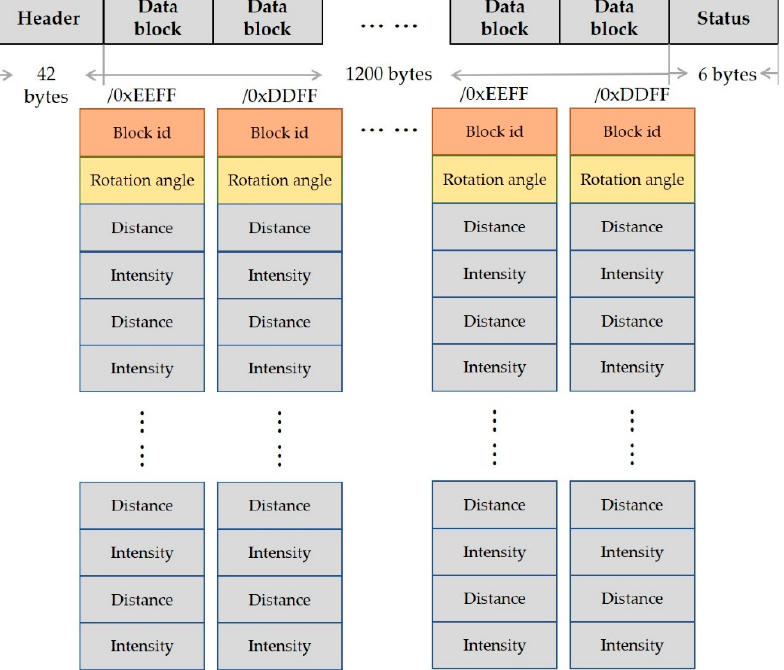
Figure 3. The data parsing format of LiDAR.